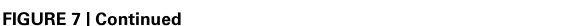
FIGURE 7 | Continued The expression of the S. plymuthica A153 zmn gene cluster is growth phase-dependent and post-transcriptionally regulated by the RNA chaperone Hfq. (A) Transcription of the zmn gene cluster throughout growth in Serratia plymuthica A153.The dip in β − galactosidase activity post − peak suggests the enzyme is subject to proteolytic turnover, which has been observed previously in A153 (Matilla and Salmond, unpublished results). (B) Different carbon sources have different effects on the correlation between zmn gene transcription and the bioactivity of A153A − derived supernatants. β − galactosidase activity was measured in strain A153JH6 grown in 1C − OMM supplemented with 15 mM sorbitol, mannitol, sucrose, or gluconic acid. (C) Expression of the zmn gene cluster is regulated by the RNA chaperone Hfq. β − galactosidase activity was measured in strain A153JH6 in the presence (red) or absence (blue) of a chromosomal hfq gene deletion. (A,B) The strains were grown in LB at 25 ◦ C and β -galactosidase activities were measured in strains expressing chromosomal zmn13::lacZ fusions. In all panels solid symbols represent growth of the corresponding strains whereas open symbols represent